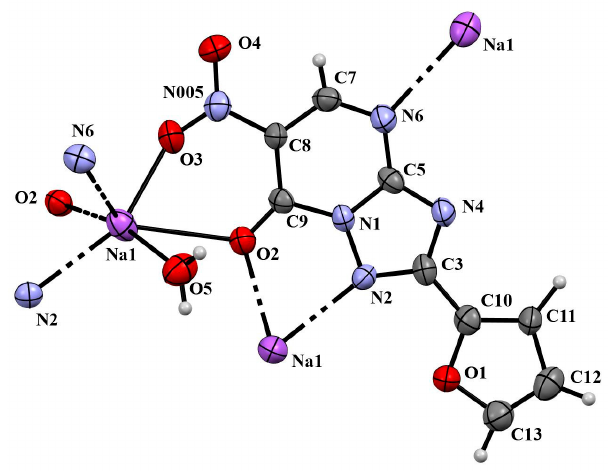
Figure 1. The molecule of compound A in the thermal ellipsoids of the 50% probability level and contacts with nearest atoms.